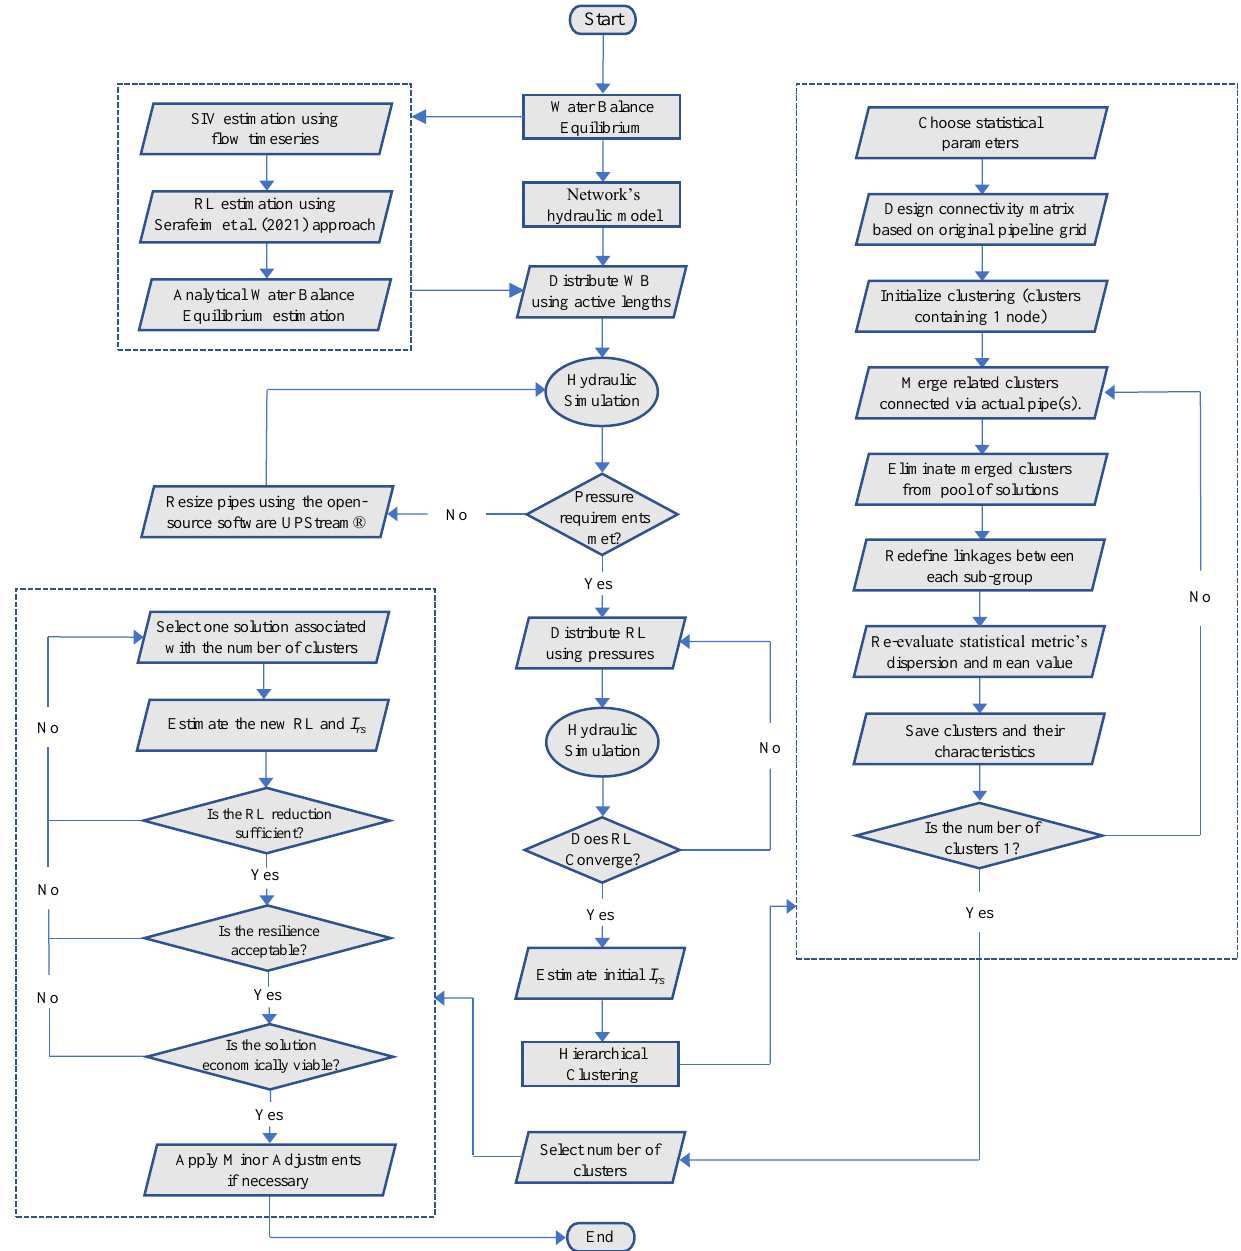
Figure 2. Flow chart of the algorithmic steps of the developed approach.